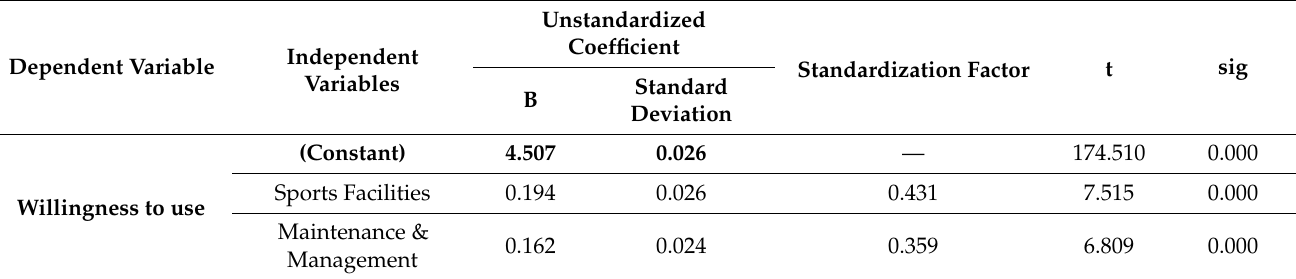
Table 6. Results of multiple regression